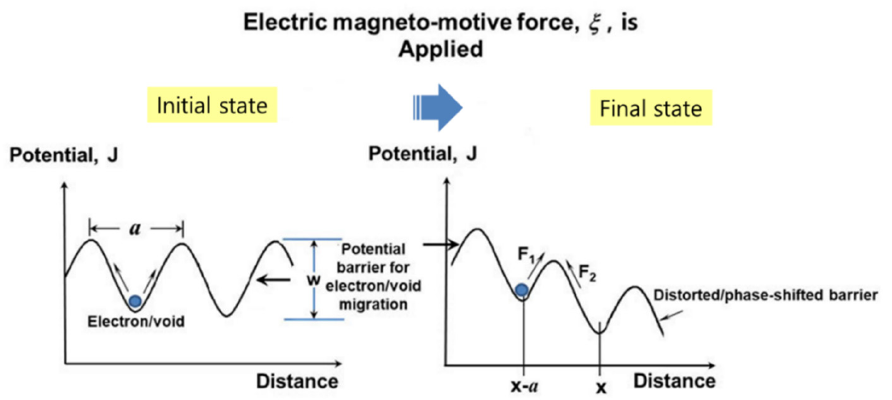
Figure 5. Potential exchange in material such as silicon as electrical field is exerted.